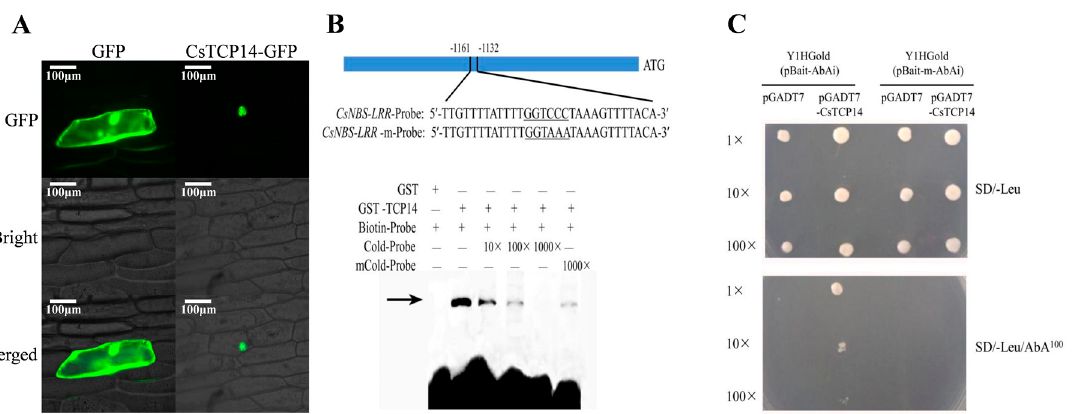
Figure 5. Transcriptional repression of CsTCP14 with defense gene CsNBS-LRR ( Cs6M344280.1 ). ( A ) The pYBA1332::CsTCP14-GFP was localized in nuclear of the onion epidermal cell, indicated as CsTCP14-GFP. The empty vector of pYBA1332::GFP was set up as control, indicated as GFP. The scale bar was 100 µ m. ( B ) The EMSA experiment showed that the GST-TCP14 fusion protein was attenuated gradually by increasing the concentration of unlabeled cold-probes, while as it was reappeared after incubated with the mutated cold-probes. The band was indicated by the black arrow, and the experiment was performed in three replications. ( C ) The Y1H experiments showed that the positive clones were decreasing gradually when increasing the dilution concentration of pGADT7- CsTCP14. The empty vector pGADT7 was set up as negative controls, and three replications were performed.